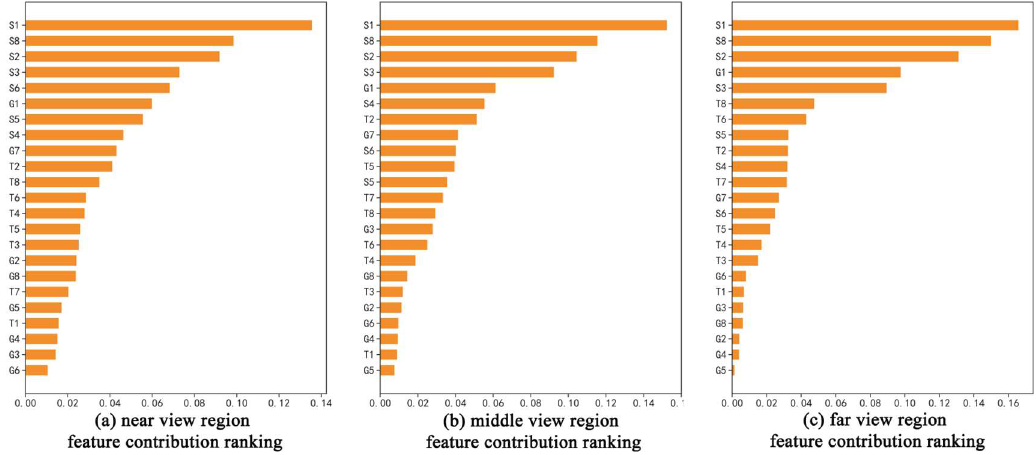
Figure 7. Feature contribution ranking.